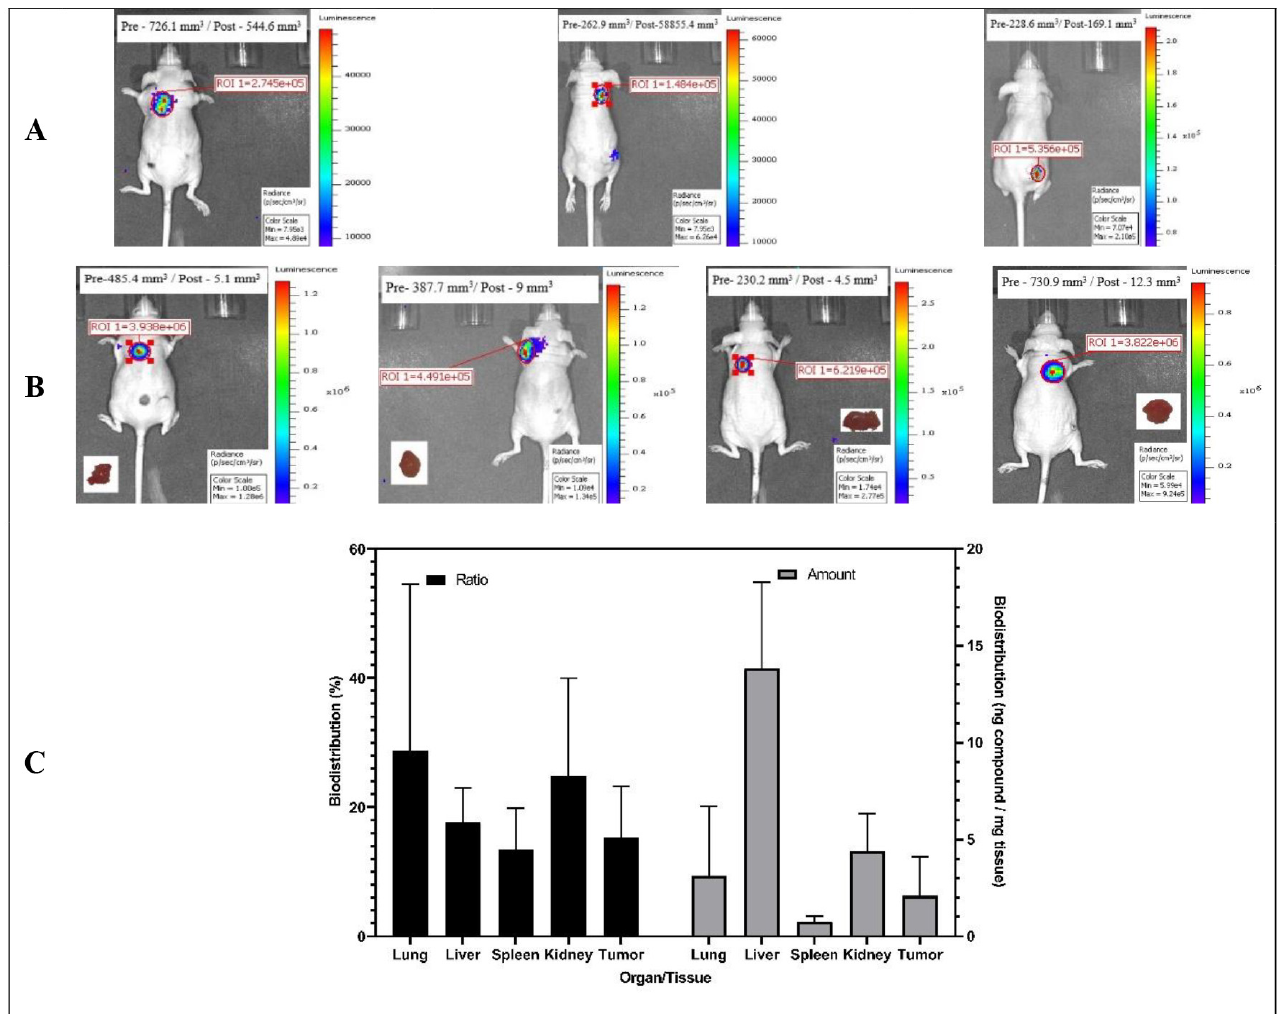
FIGURE 5 - A) Initial IVIS-Spect images and tumor volumes of the control group. (Pre: initial tumor volume and Post: tumor volume on the final day of the experiment). The tumor volumes of the control group remained unchanged or increased during the study. B) Initial IVIS-Spect images, initial and final tumor volumes, and tumor images of new compound-treated mice. After 6 six doses of new compound administration, the tumor volume decreased significantly. C) Biodistribution study